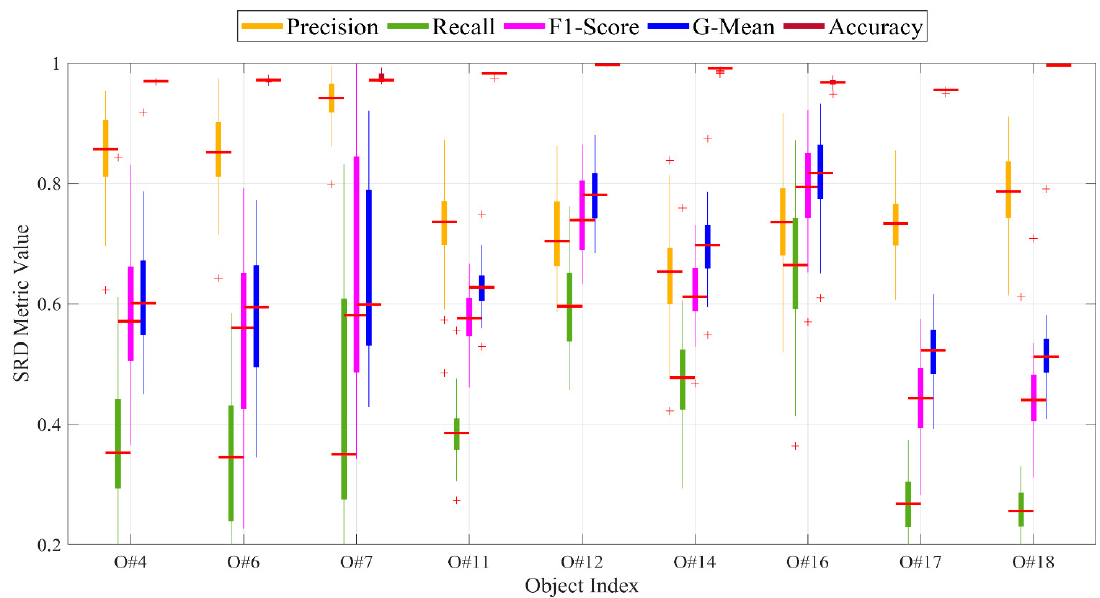
Figure A1. Evaluation results for SRD performances of proposed method for 122 specular reflected images (121 sub-apertures + 1 maximum) of nine sample objects separately using different SRD metrics.